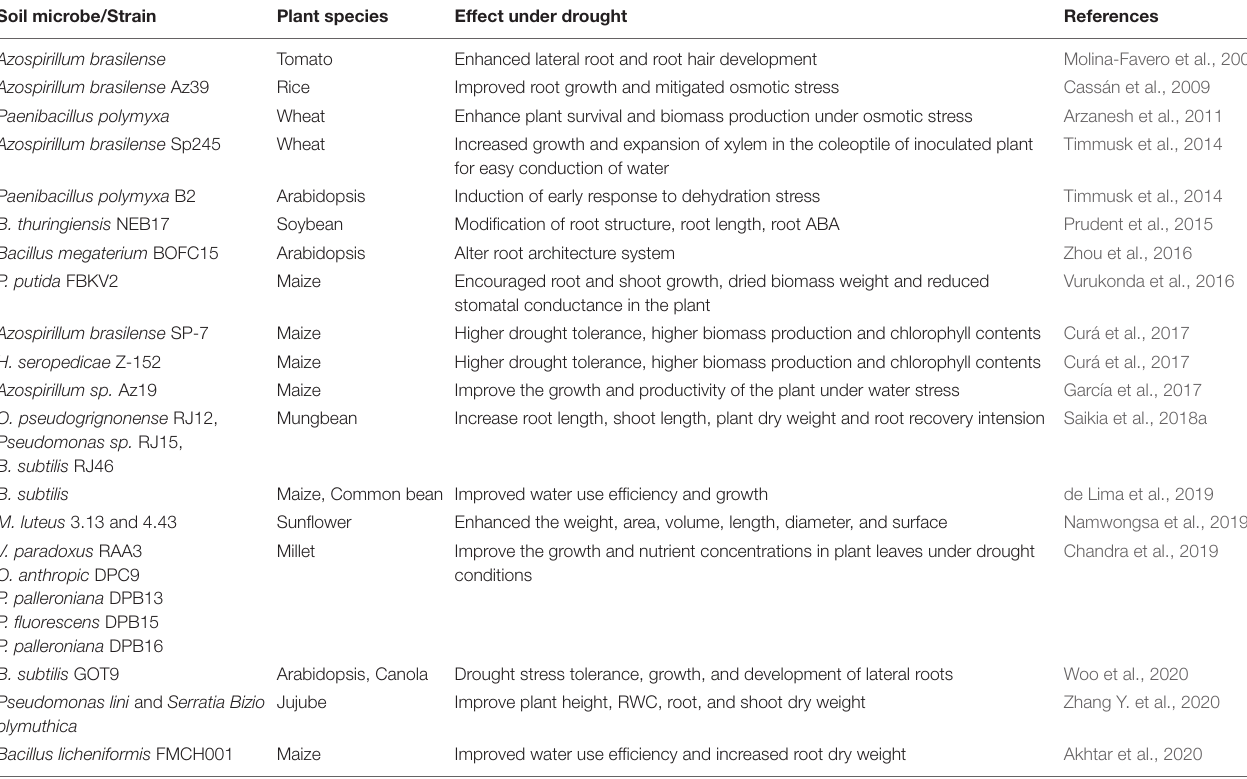
TABLE 1 | Alteration in root morphology, plant growth, and development by PGPR under drought